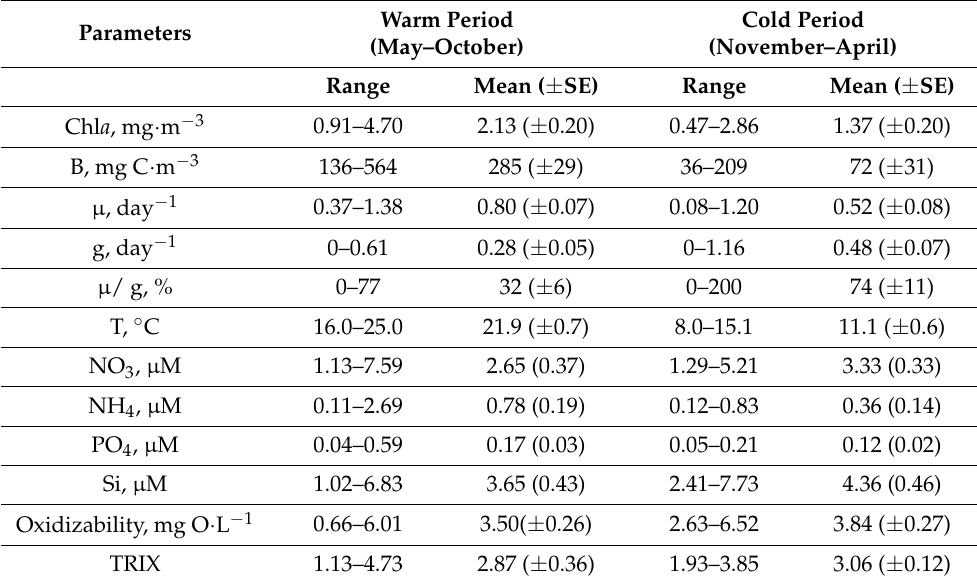
Table 4. Hydrochemical and hydrobiological parameters in the cold and warm periods of 2020.